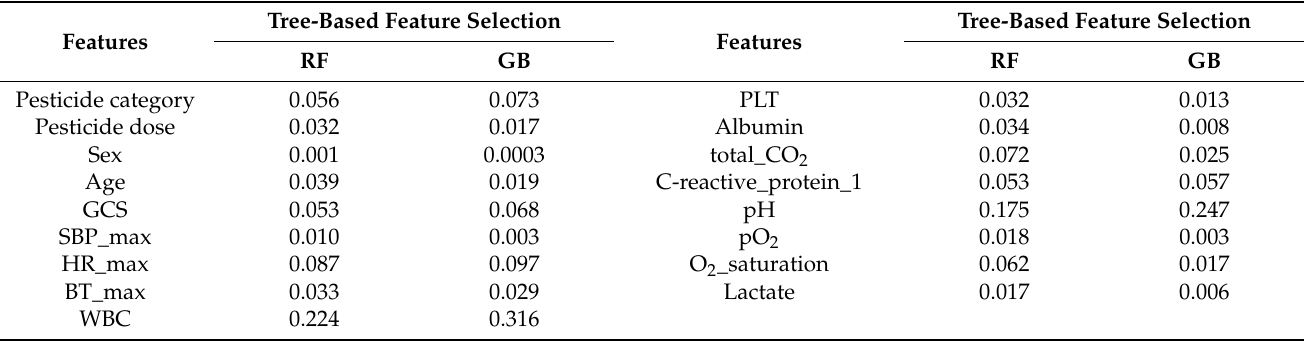
Table 2. Performance result of tree-based feature selection